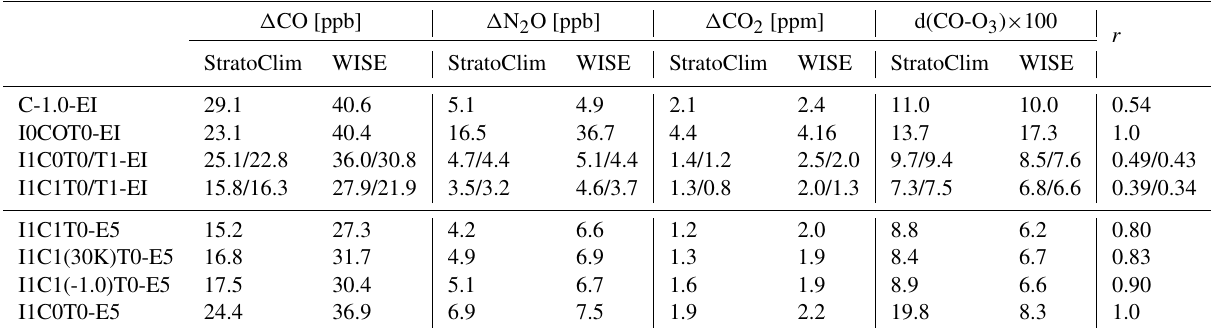
Figure 6. CO–O 3 correlation-based metrics. Observed (colored) versus simulated (black) CO–O 3 correlation for all flights of the WISE campaign. The observed data are color-coded with the mean (Euclidean) distance d (dist) calculated in the CO–O 3 space after normalizing = (x o − x s − y s ) 2 + (y o ) 2 denoting the square of the Euclidean distance between CO and O 3 data by 200 and 3000ppbv, respectively. With d 2 i i i i i the observed (“o”) and simulated (“s”) (normalized) CO/O 3 ( x/y ) value pairs i ; d is defined as the arithmetic mean over all d i values. Note √ that d is a dimensionless quantity varying between 0 and 2 (here multiplied with 100). (a) Baseline run (C-1.0-EI), (b) isentropic mixing and unresolved convection (I1C1T0), and (c) pure advection (I0COT0). Table 4. Rating of the EI- and E5-driven runs (upper and lower parts of the table) in terms of the root mean square differences (cid:49) calculated over the vertical ranges listed in Table 3 and in terms of the mean deviations d from the observed CO–O 3 correlation during StratoClim and WISE (smallest values of (cid:49) an d indicate the best performance). These four metrics m i are normalized by their maximal values within each of the considered group and are used to calculate the cumulative rating parameter r defined as a sum of all metrics m i normalized by the sum maximum (i.e., r = 1 means the worst case and smallest value of r means the best case). While for the first four cases (EI runs), r is calculated relative to the pure advection case (I0COT0-EI), and r value of the last four cases (E5 runs) are determined relative to the pure isentropic run